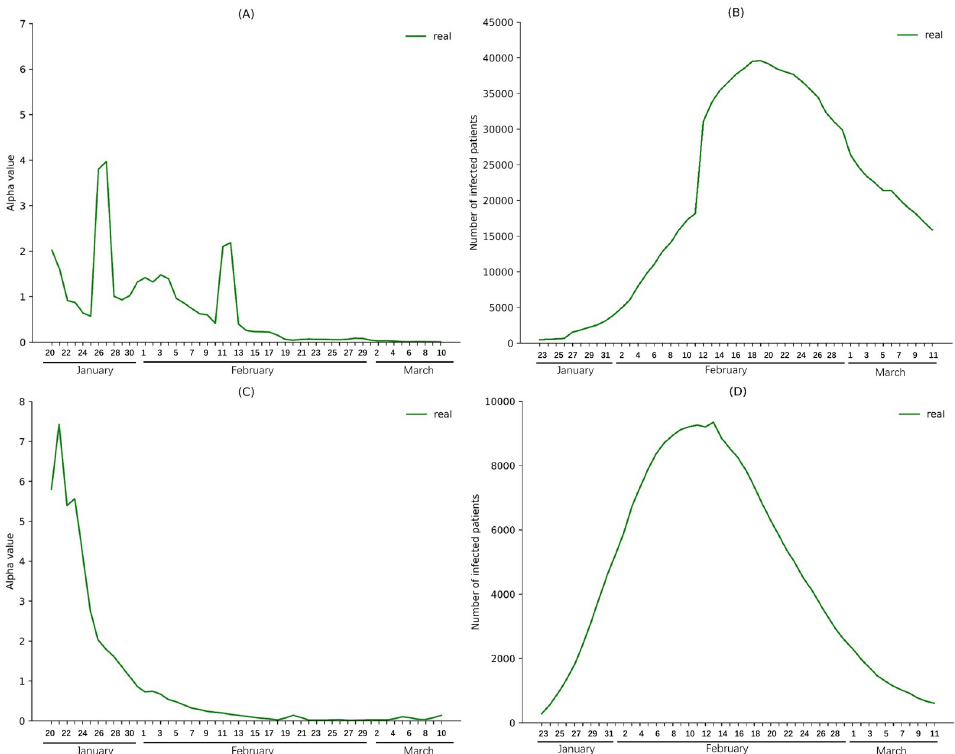
Fig 2. Real-world α values and numbers of infections in Wuhan city from January 20 to March 10 and in China excluding Hubei from January 23 to March 11. Real α values (A) and numbers of infections (B) in Wuhan city; real α values (C) and numbers of infections (D) in China excluding